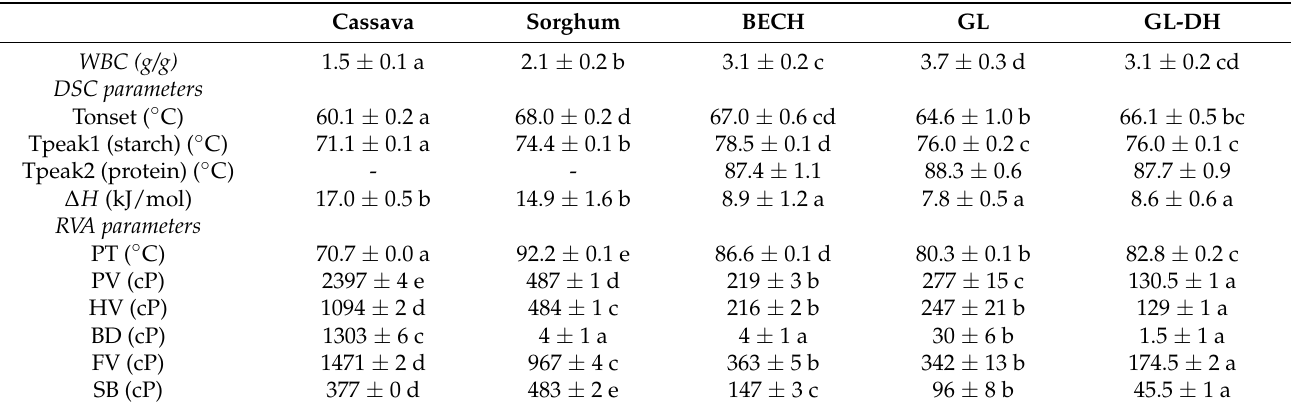
Table 3. Physicochemical properties of the flours used in the study. Cassava Sorghum